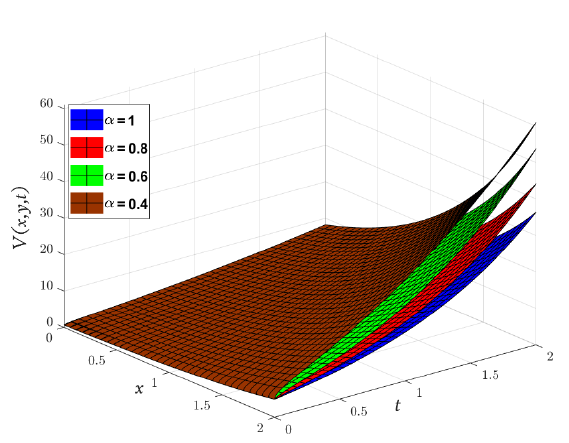
Figure 7. Three-dimensional plots of the approximate and exact solutions of V ( x , y , t ) (Example 3) using the LADM.